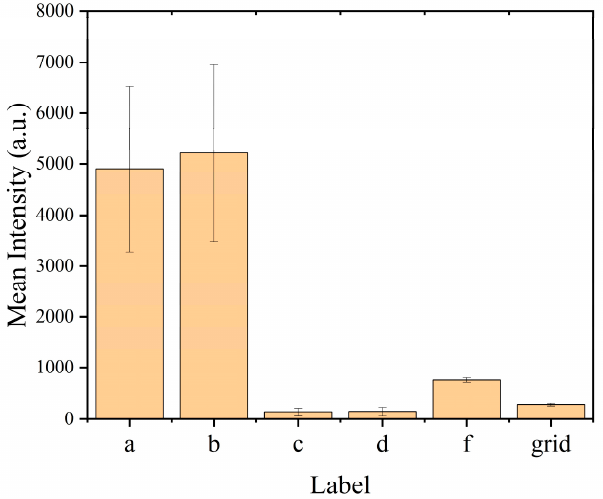
Figure 5. Fluorescence intensity of different cells and blank grid. The labels a, b, c, d and f correspond to the letter labels in Figure 4. The label grid indicates the autofluorescence of blank grid as a control. The fluorescence intensity of different cells was the net value after deducting the fluorescence of the blank grid. The number of pixels for calculating the mean intensity was, respectively, 2162, 1648, 1331, 1341, 2801 and 14022. Table 1. Criterion for determining cell status on-line